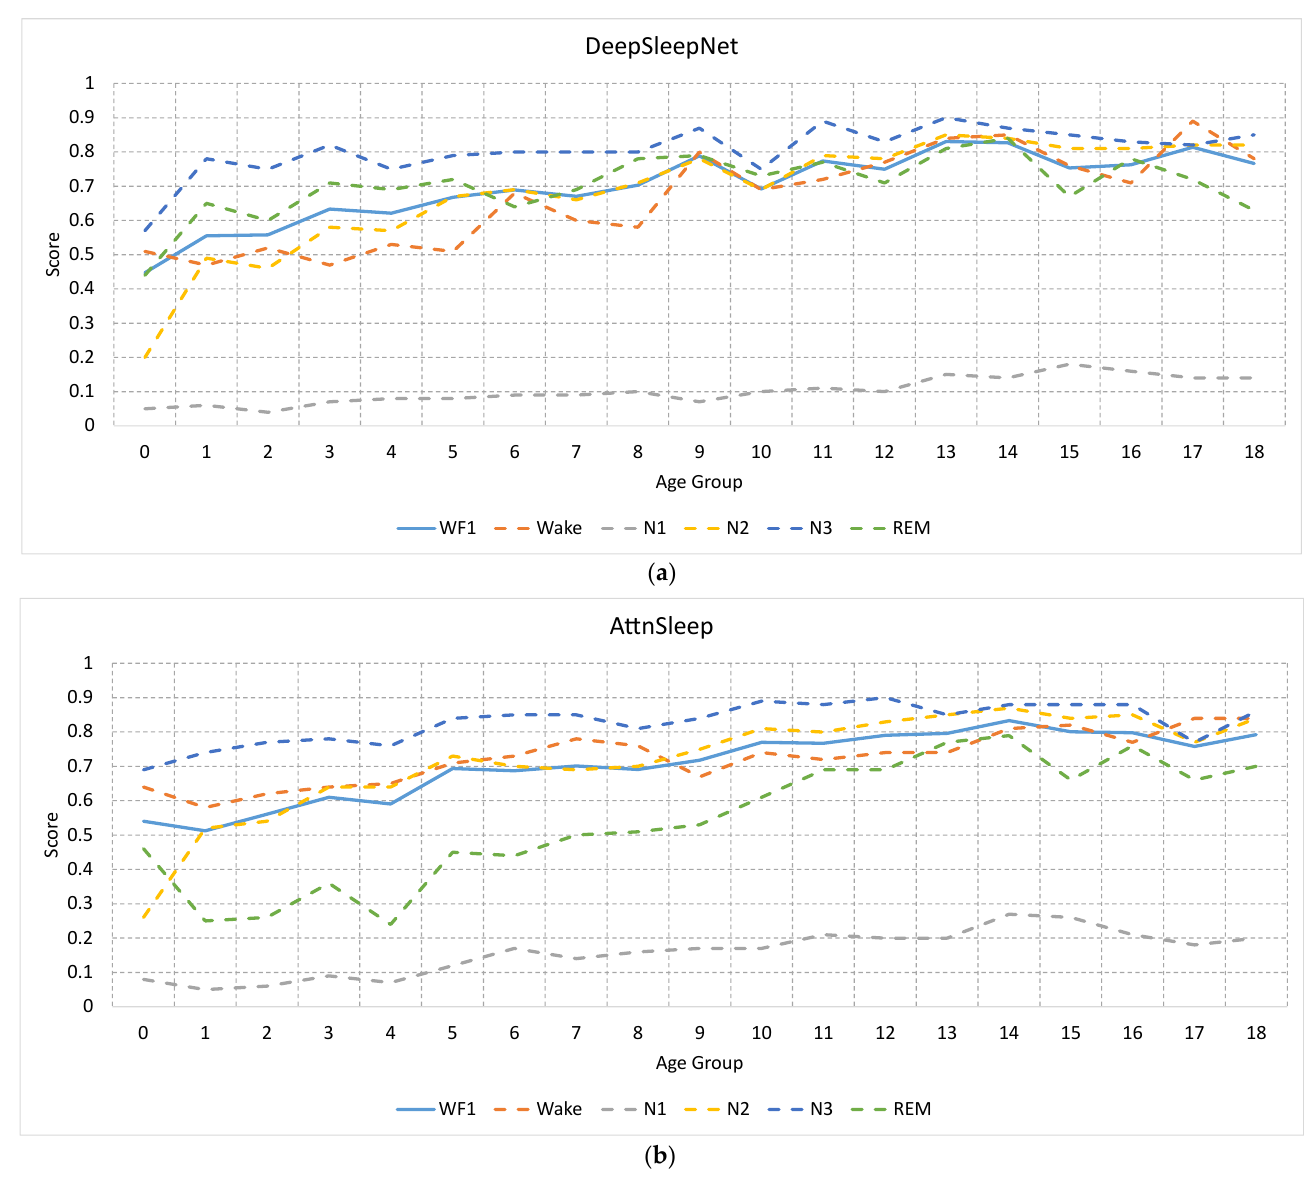
Figure 8. The performance of a model trained on adult EEG signal over different age ranges using different channels for ( a ) DeepSleepNet and ( b ) AttnSleep methods. As seen, the model had the lowest WF1 score when tested against infant EEG signal and increased gradually with the increase of the participants’ age.